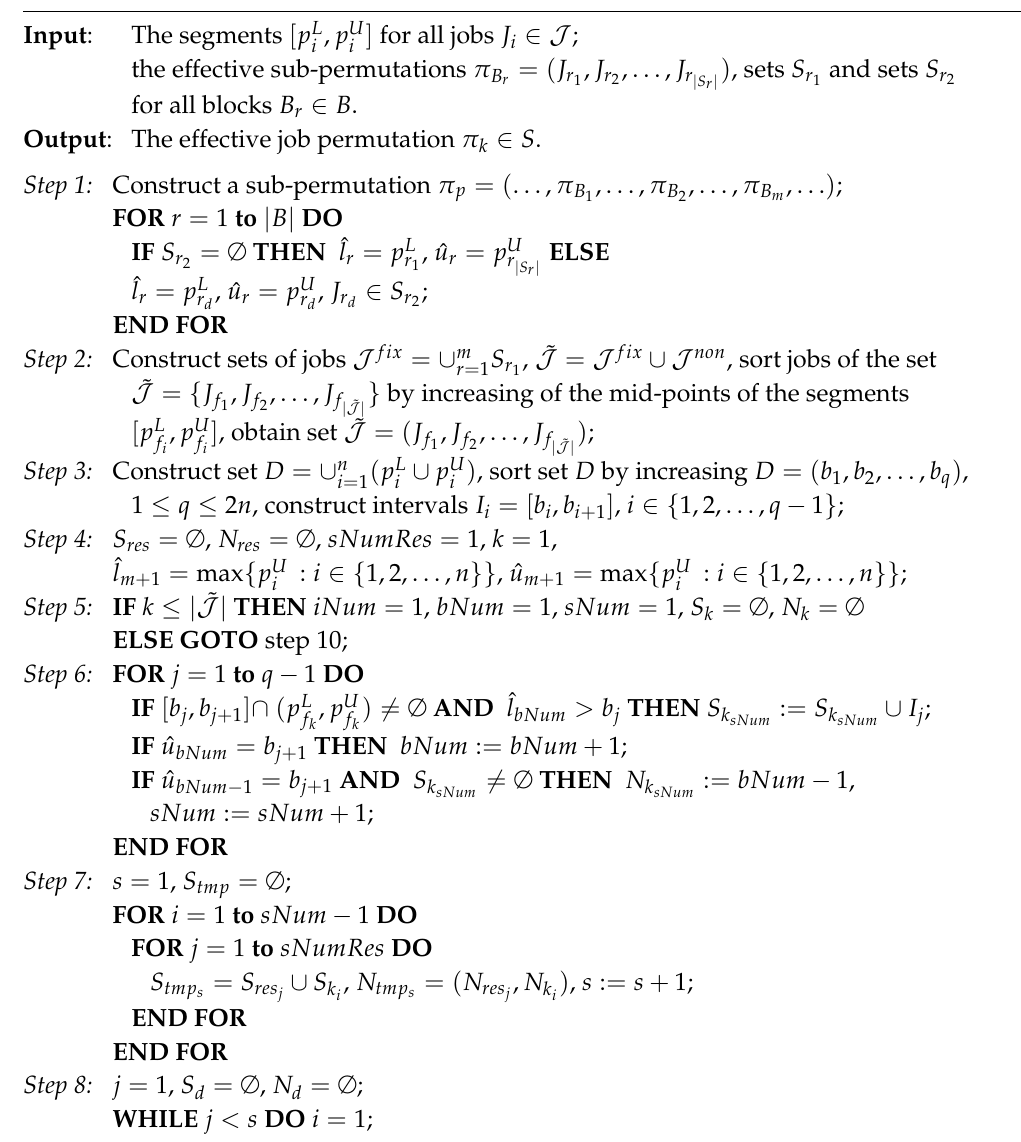
Algorithm 3: Construction of the effective permutation π k ∈